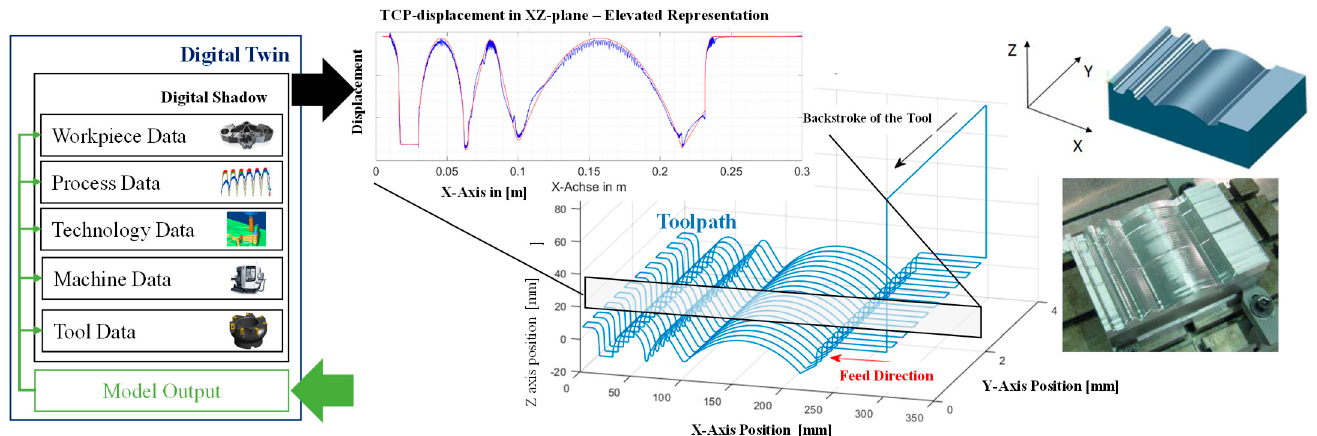
Figure 2. Determination of the TCP–displacement for an example machining of a tool ‐ making test profile cycle.